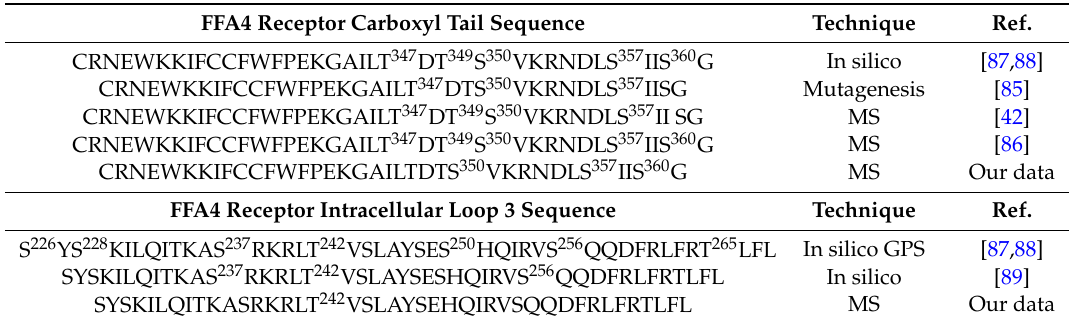
Table 2. FFA4 receptor phosphorylation sites. Amino acids in red indicate phosphorylation sites; references